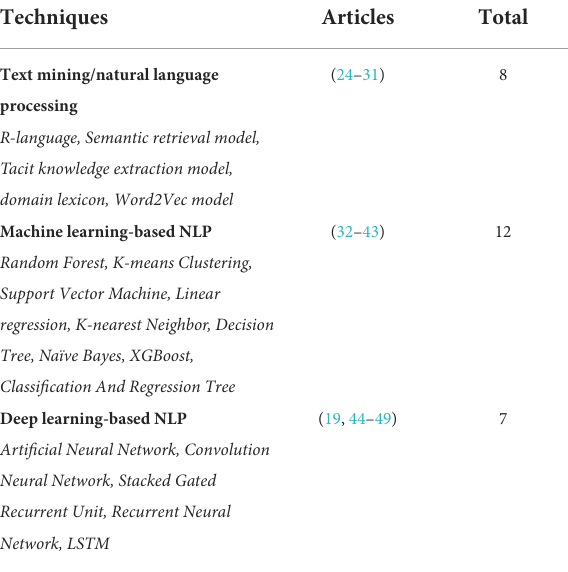
TABLE 3 Similarity of techniques in existing related